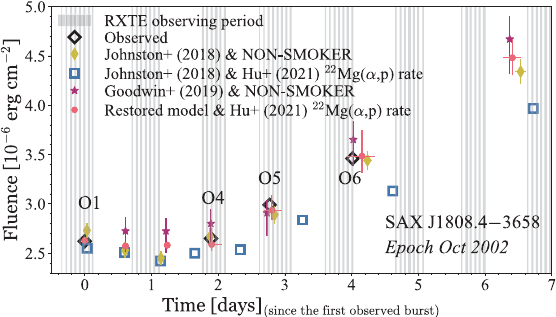
Figure 2. The bursts’ fluences and times of the SAX J1808.4 − 3658 PRE burster, recorded by the Rossi X-ray Timing Explorer (RXTE) [1], based on Johnston et al . [6] and Goodwin et al . [7] models with N on -S moker 22 Mg( α, p) reaction rate, and the restored Johnston et al. model with Hu et al. 22 Mg( α, p) reaction rate [8]. The light curves of observed (and modeled) bursts O1 (B1), O4 (B4), O5 (B5), and O6 (B6) are plotted in Fig.